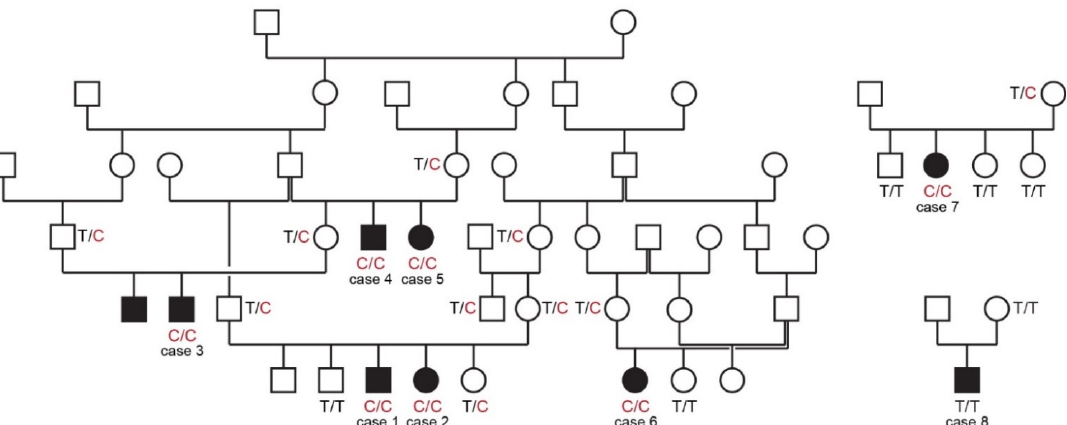
Figure 1. Pedigrees of affected Vizslas with disproportionate dwarfism. Circles represent females and squares males. Affected dogs are indicated by filled symbols. Six of the eight cases could be traced back to common ancestors in one large pedigree shown on the left side. Genotypes at the PCYT1A: c.673T>C variant are indicated for animals from which DNA samples were available. At birth, affected puppies were not visibly distinguishable from their unaffected littermates. Deviation from the typical limb length and conformation became increasingly evident from three to five weeks of age. Affected puppies developed shorter and more bowed limbs than their littermates and a “knobby” appearance of the carpi. As adults, affected individuals were shorter than their close relatives with shoulder heights of 42.5 – 50.8 cm. This was lower than the American Kennel Club breed standard, which specifies 55.9 – 61.0 cm (22 – 24 inches) for males and 53.3 – 58.4 cm (21 – 23 inches) for females. Seven affected dogs maintained a standard size and shape of the head and trunk. Case 8 was of similar height to the other cases, but additionally had mandibular brachygnathism (Figure S2; Table S1). On orthopedic examination, there was marked shortening of the brachium, an abducted elbow position and shortening and bowing of the antebrachium with thickening in the region of the metaphysis. However, significant carpal valgus or varus was not observed. Affected individuals maintained a wide-based stance in the forelimbs. The hindlimbs were similarly shortened, although in most of the cases they appeared slightly less affected than the forelimbs (Figure 2). At the time of writing, affected dogs were between two and seven years of age; none had systemic illnesses or vision problems diagnosed by their primary care veterinarians. One dog was evaluated by a veterinary